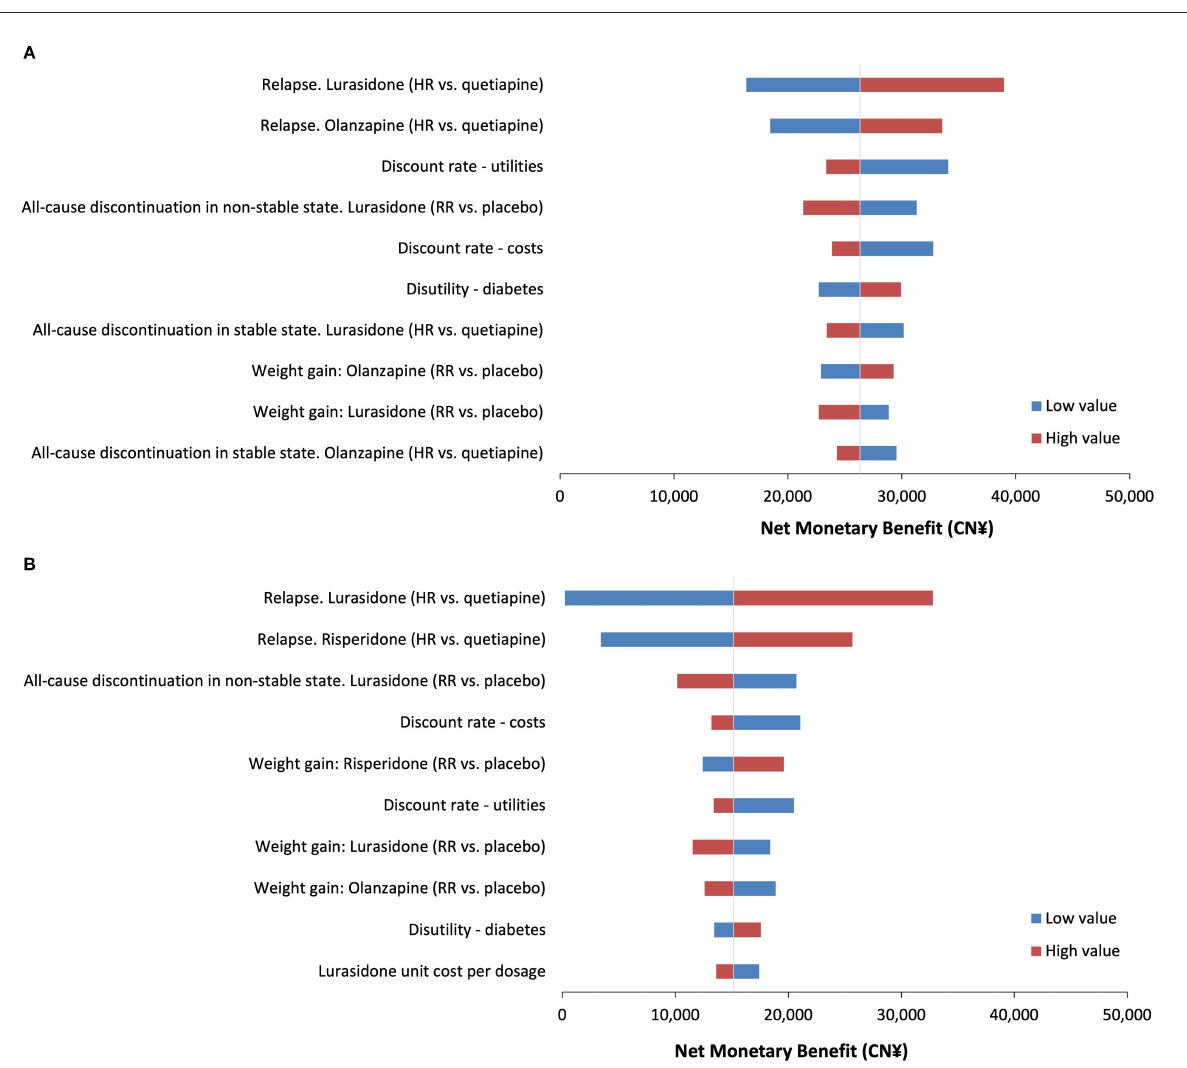
of Scotland and Wales healthcare services evaluated the cost- effectiveness of lurasidone vs. aripiprazole through a 10-year Markov model (23), the structure of which was adopted